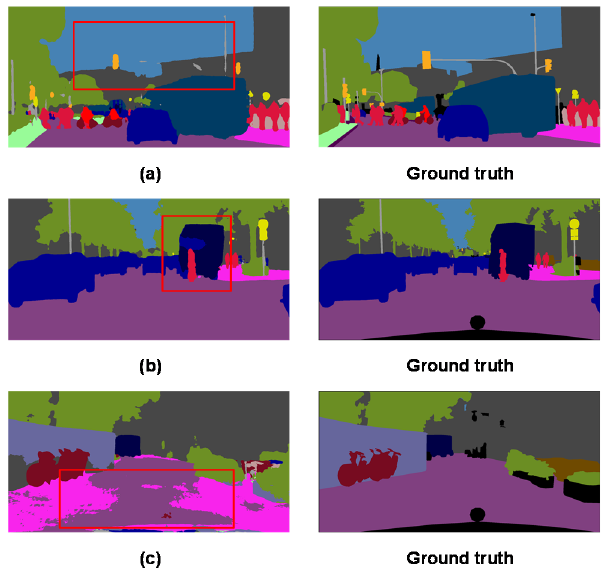
Figure 1. Some semantic segmentation issues observed in the Cityscapes dataset. ( a ) Missing small and thin objects. ( b ) Incorrect segmentation of similar parts. ( c ) Incomplete segmentation of large objects.